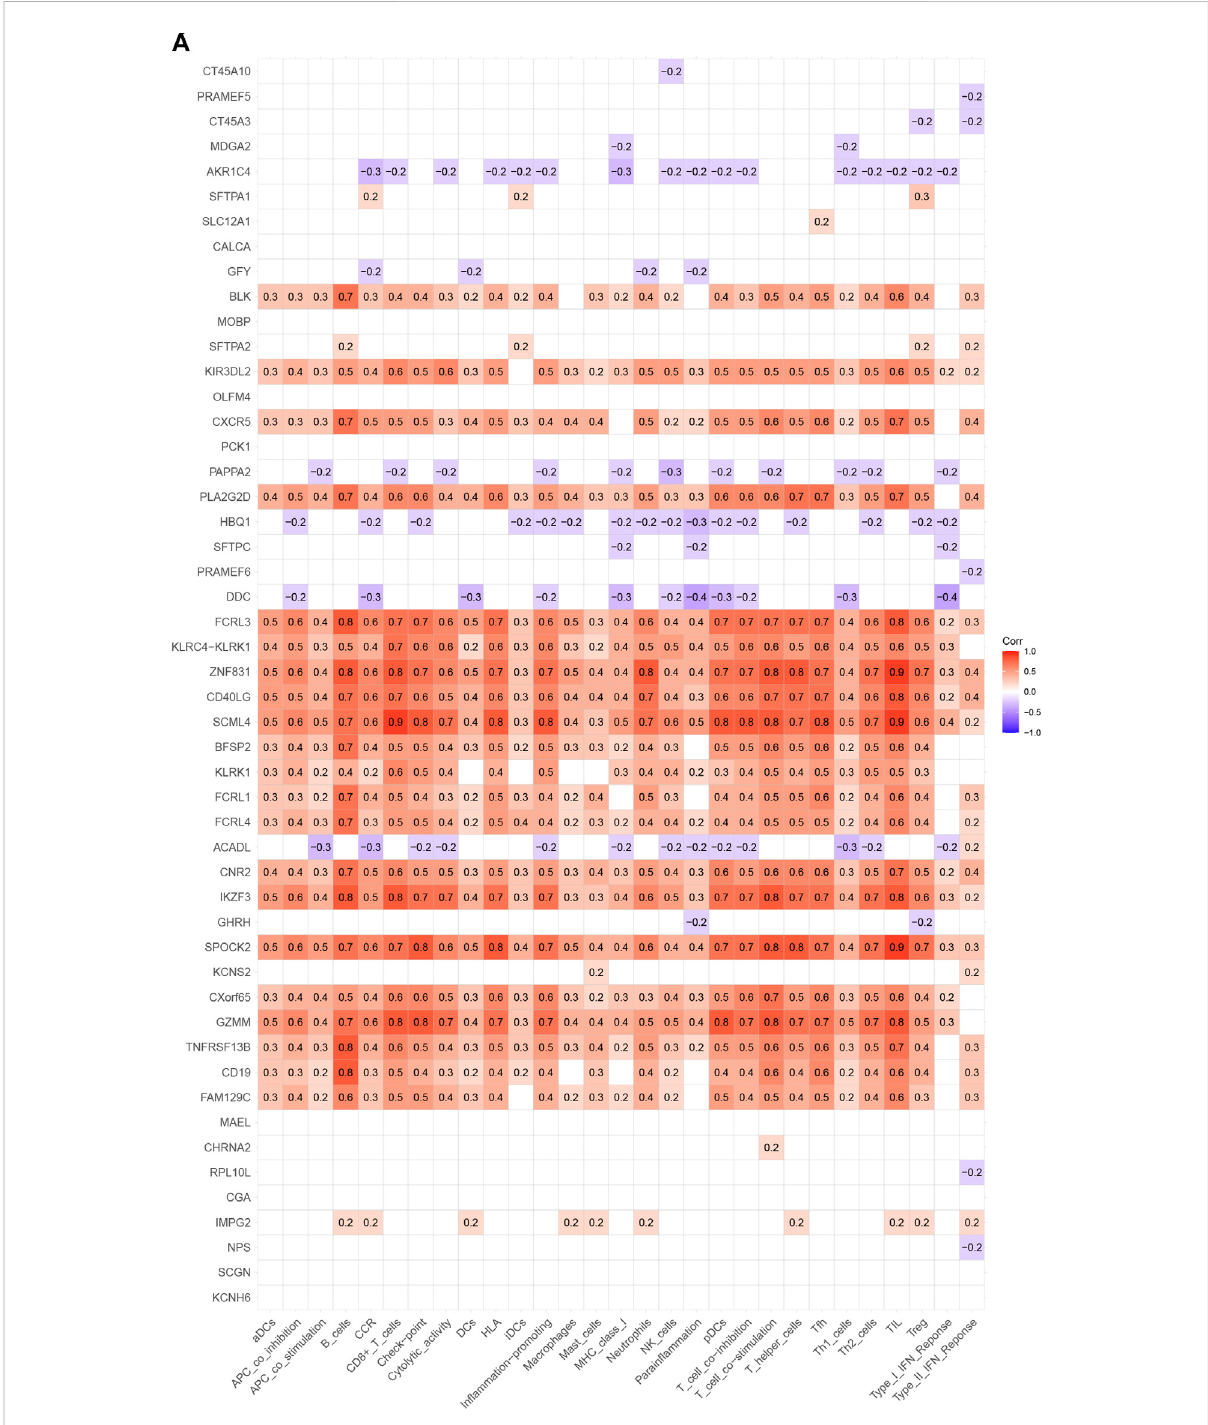
FIGURE 7 Correlation analysis of genes with immune cells and immune function in